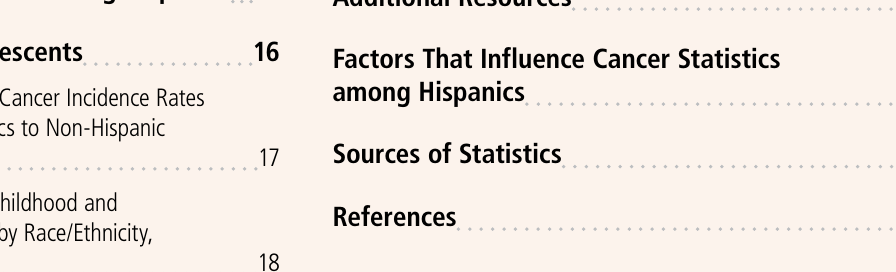
Table 6. Current Cigarette Smoking, Electronic Cigarette Use, and Alcohol Consumption (%), Adults 18 Years and Older, US, 2017 Table 7. Tobacco Use and Alcohol Consumption (%), High School Students, US, 2017 Figure 8. Current Cigarette Smoking (%) Trends, Hispanic and Non-Hispanic White High School Students, Figure 9. Obesity (%) Trends in Mexican Americans and Non-Hispanic Whites by Age, US, 1976-2016 Figure 10. Excess Body Weight (%) in Hispanics and Non-Hispanic Whites by Age, US, 2015-2016 23 Table 8. Cancer Screening Test Use (%), Adults, US, 2015 28 Factors That Influence Health: Socioeconomic Status and Cultural Values and Beliefs 30 Table 9. Socioeconomic Characteristics (%) by Race/Ethnicity and Hispanic Origin, US, 2012-2016 30 Table 10. Health Care Access Characteristics (%) by Race/Ethnicity and Hispanic Origin, US, 2016-2017 31 How the American Cancer Society Saves